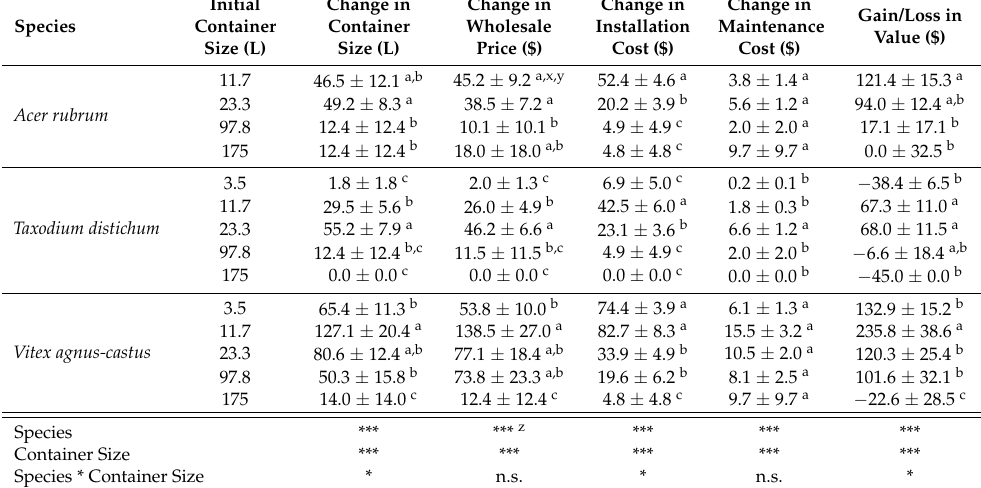
Table 1. Means and Analysis of Variance of the effects of tree species and initial container size on changes in size, price, costs, and value of trees after transplanting to the landscape and growing for two